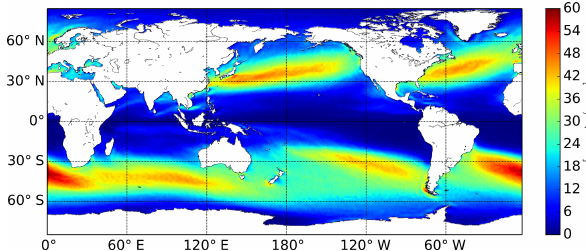
Figure 5. Mean number of atmospheric rivers detected per year. Data were retrieved from Guan and Waliser (2015) for the period 1979–2014 with a 6h time step.